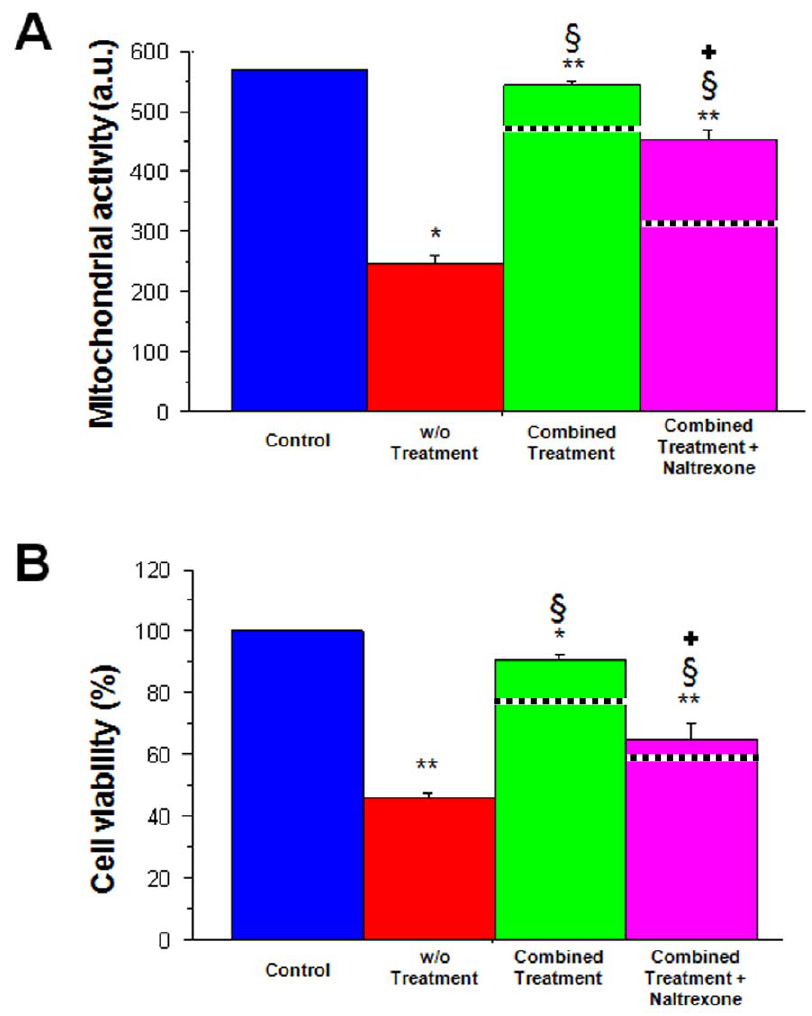
Figure 4. Opioid-mediated neuroprotection of PRNCs exerted by combination therapy of moderate hypothermia, MSCs and DADLE. Results revealed that OGD reduced mitochondrial activity and cell viability in PRNCs under normothermic condition (w/o treatment). The combined treatment, with or without DADLE, significantly improved both mitochondrial activity and cell viability in PRNCs, which was significantly reduced by opioid antagonist naltrexone. MTT: **p , 0.0001 vs. control; *p , 0.05; 1 p , 0.0001 vs. without treatment; p , 0.0001 vs. combined treatment. Cell Viability: **p , 0.0001 vs. control; *p , 0.005 vs. control; 1 p , 0.0001 vs. without treatment; p , 0.0001 vs. combined treatment. Dashed lines indicate combined treatment of moderate hypothermia and MSCs without DADLE. a.u.=absorbance